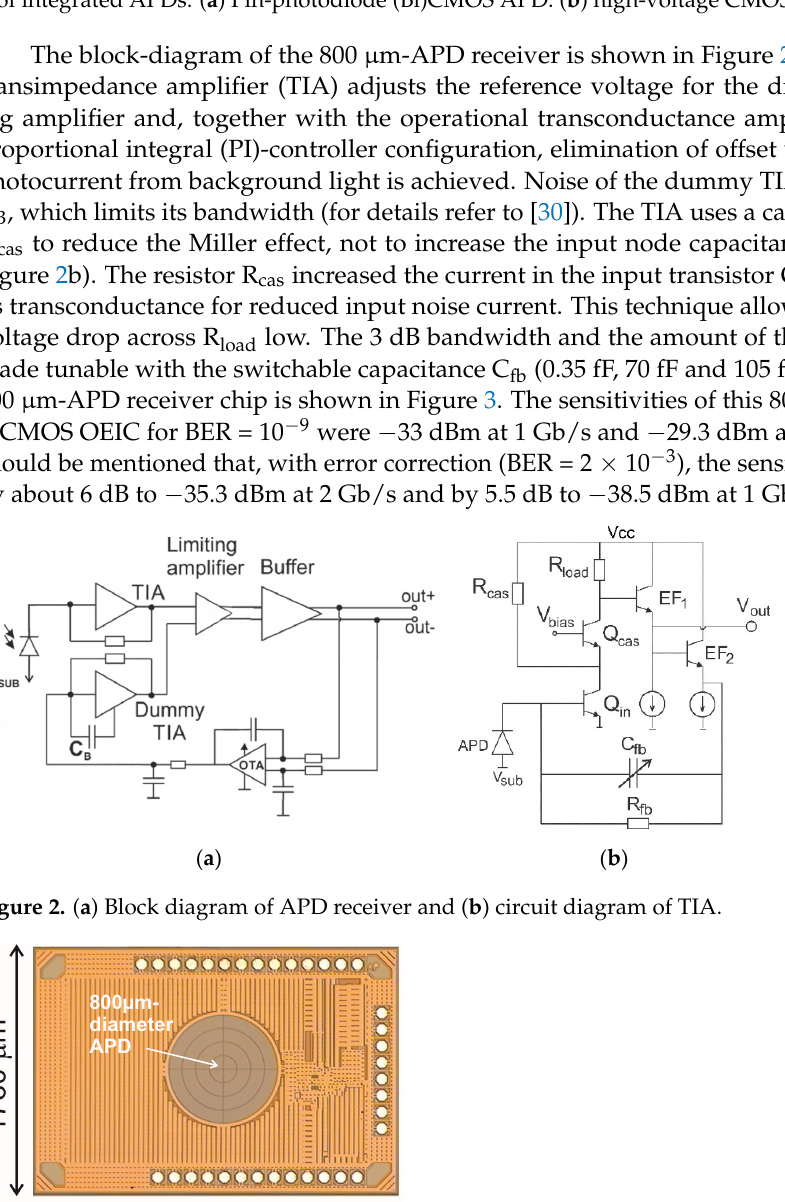
Figure 3. Chip photo of 800 µm-diameter APD receiver. Receivers with the HV-APD were realized with APD diameters of 200 and 400 µm and showed for 675 nm, 1 Gb/s, BER = 10 − 9 , and PRBS31 sensitivities of − 35.5 and − 34.7 dBm [31], respectively.